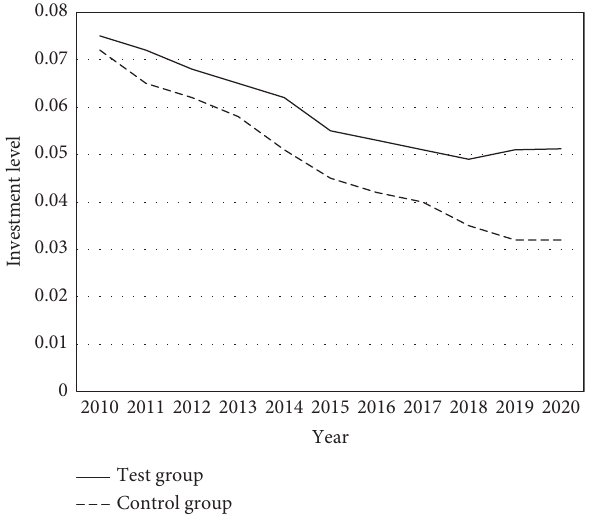
Figure 6: Time trends of green enterprise investment Table 4: Descriptive statistics for the model of the relationship between green financing and green enterprise investment efficiency. Variable